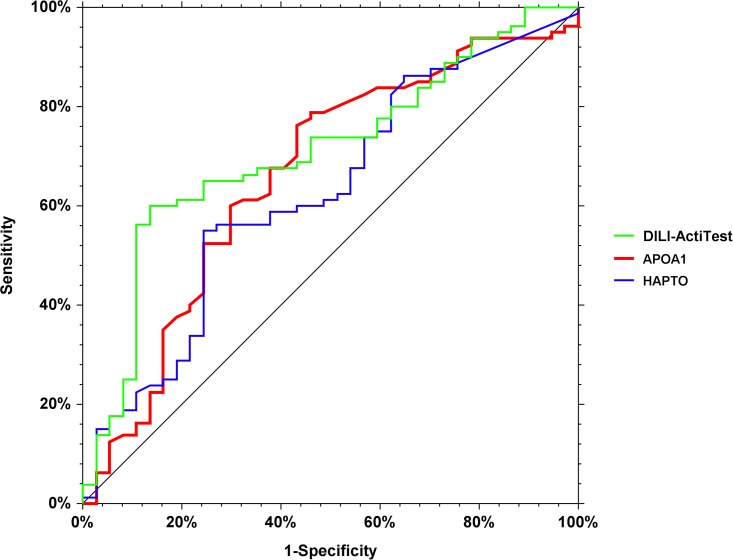
Performances of DILI-ActiTest, apoA1 and haptoglobin, for the prediction of recovery.DILI-ActiTest ‘s AUROC = 0.723 (95%CI 0.610–0.806 P<0.001 vs. 0.5). The AUROCs of APOA1, and HAPTO were 0.663 (0.536–0.76; P = 0.004 vs 0.5; P = 0.14 vs DILI-ActiTest), and 0.619 (0.496–0.718; P = 0.04 vs 0.500; p = 0.05 vs DILI-ActiTest).